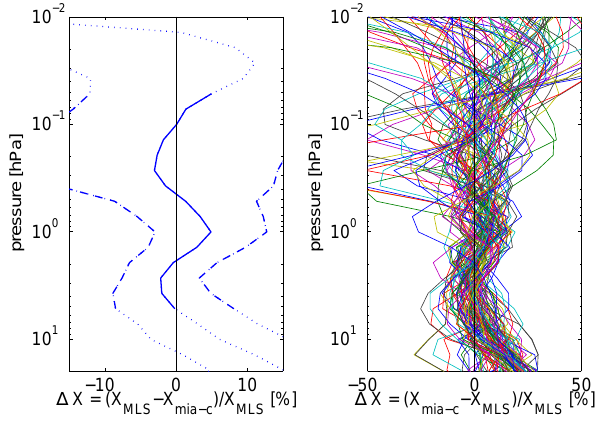
Fig. 15. Relative difference between the measurements of MIAWARA-C and MLS, mean value and standard deviation (left) and single profile comparisons right.